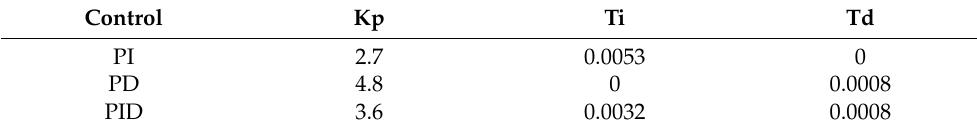
Table 2. Control parameters for secondary controller.